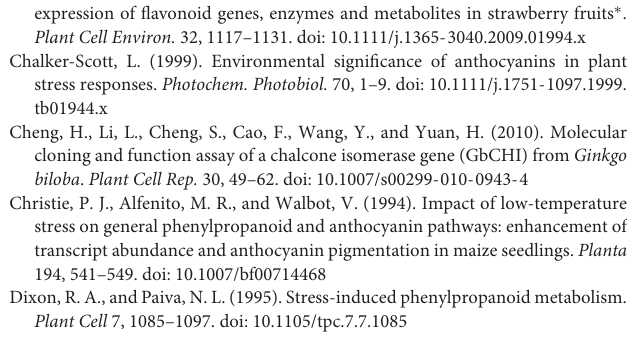
FIGURE S1 | Splitting of Ginkgo leaves before analysis. (A) Ginkgo leaf before splitting. (B) The splitting and follow-up of Ginkgo leaves. Red arrow indicates tearing of the leaf. FIGURE S2 | The necessity of short shoots in the culture system. Leaves without short shoots significantly wilted 12 h after harvest. (A) Immediately after harvest. (B) 12 h after harvest. Red arrow heads indicate short shoots. FIGURE S3 | (A) Typical fingerprint of total extract of post-harvest Ginkgo leaves. Numbers on the peaks are candidates for UV absorption spectrum analysis. (B) UV absorption spectrum analysis of eight peaks selected in the fingerprint. The wavelengths of two absorption peaks are marked. FIGURE S4 | Mass spectrometric analysis of peak No. 3, which is estimated to be rutin. FIGURE S5 | Mass spectrometric analysis of peak No. 5, which is estimated to be narcissoside. FIGURE S6 | Identification of rutin in post-harvest Ginkgo leaves. (A) Identification of peak No. 3 (indicated by red arrow) with the rutin standard. (B) The ultraviolet absorption spectrum of peak No. 3. (C) The UV absorption spectrum of the rutin standard. FIGURE S7 | Identification of narcissoside in post-harvest Ginkgo leaves. (A) Identification of peak No. 5 (indicated by red arrow) with the narcissoside standard. (B) The UV absorption spectrum of peak No. 5. (C) The UV absorption spectrum of the narcissoside standard. FIGURE S8 | The responses of naturally grown Ginkgo trees to NaCl treatment. (A) The phenotype of Ginkgo trees used for NaCl treatment. (B) Typical fingerprint of the total extract of naturally grown Ginkgo leaves. Numbers on the peaks are candidates for flavonoid content analysis. (C) Relative area changes of the six peaks after NaCl treatment. (D) Relative expression levels of flavonoid synthesis related genes after NaCl treatment. Asterisks indicate significant differences ( P < 0.01; Student’s t -test) between NaCl treatment and control. Data for independent experiments are shown (mean ± SD; n = 3). TABLE S1 | Sequences of the primers used in this